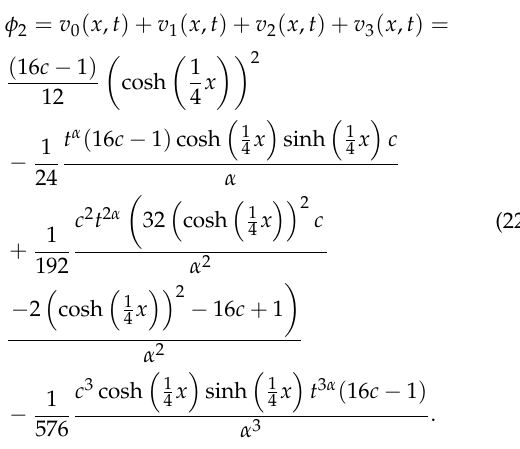
Fig. 1 and Table 1 show solutions of Eq. (16) for different values of α . Table 1 shows the approximate solutions of Eq. (19) for different values of α : α = 0.9, α = 0.95 and α =1 using only three iterations of the DJM solution (see also Fig.